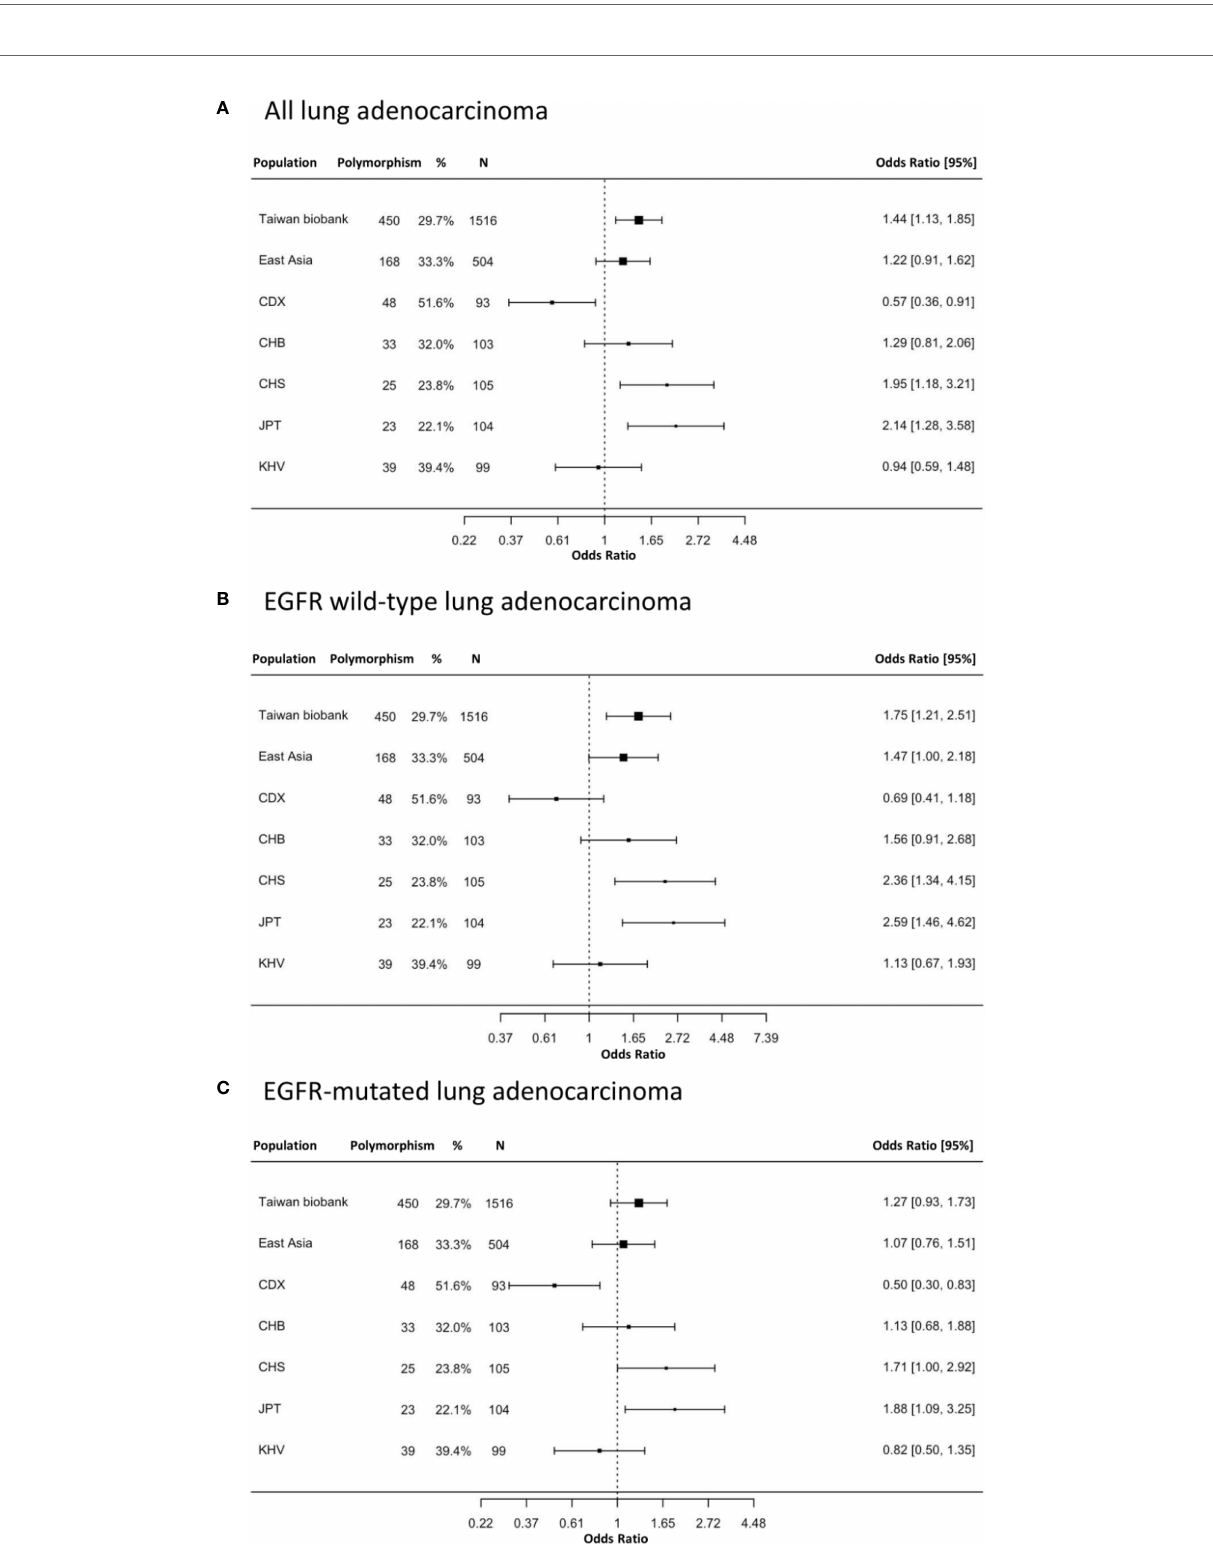
FIGURE 1 | The prevalence and odds ratios of EGFR Q787Q polymorphism in lung adenocarcinoma patients and general populations. (A) all lung adenocarcinoma (B) EGFR wild type lung adenocarcinoma (C) EGFR-mutated lung adenocarcinoma. 95% CI: 95% con fi dence interval; Taiwan Biobank (n=1,516); CDX, Chinese Dai in Xishuangbanna, China (n=93); CHB, Han Chinese in Beijing, China (n=103); CHS, Southern Han Chinese, China (n=105); JPT, Japanese in Tokyo, Japan (n=104); KHV, Kinh in Ho Chi Minh City, Vietnam (n=99). The x-axis was displayed as log transform scale and corresponding numbers of odds